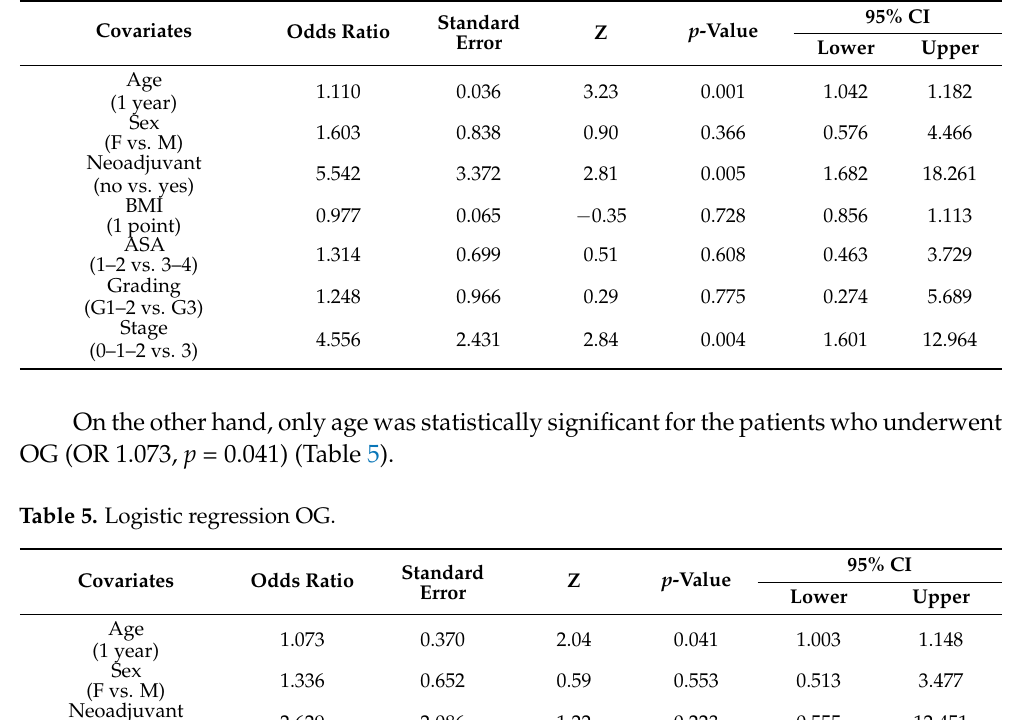
Table 4. Logistic regression LG.